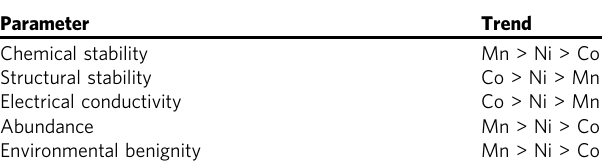
Table 3 Comparison of the characteristics of Mn, Co, and Ni in NMC cathodes.